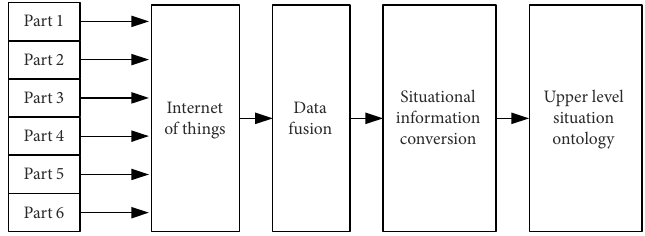
Figure 4. The framework of tourism Supply Chain scenario modeling based on polymorphic